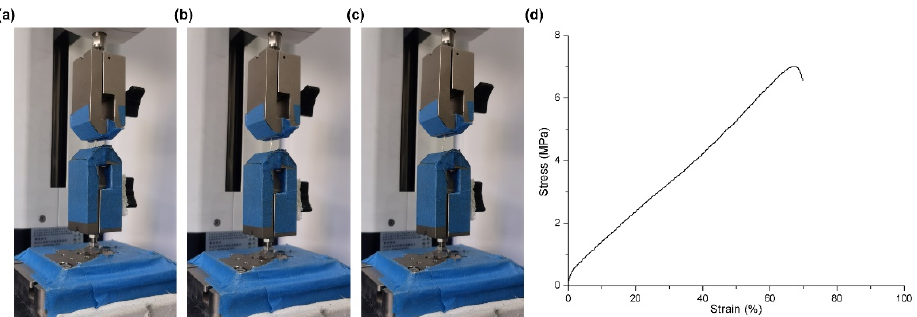
Figure 6. Tensile test of the chitin nerve conduit. ( a – c ) The conduit was performing tensile test. ( d ) Stress–strain curve of the chitin nerve conduit.